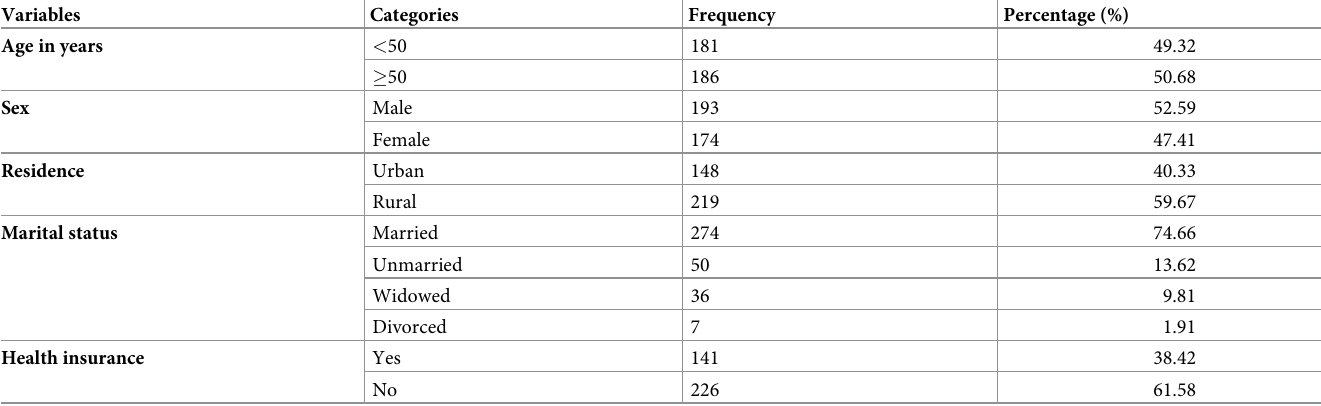
Table 1. Socio-demographic characteristics of colorectal cancer patients in Northwest Amhara Referral Hospitals (n = 367).